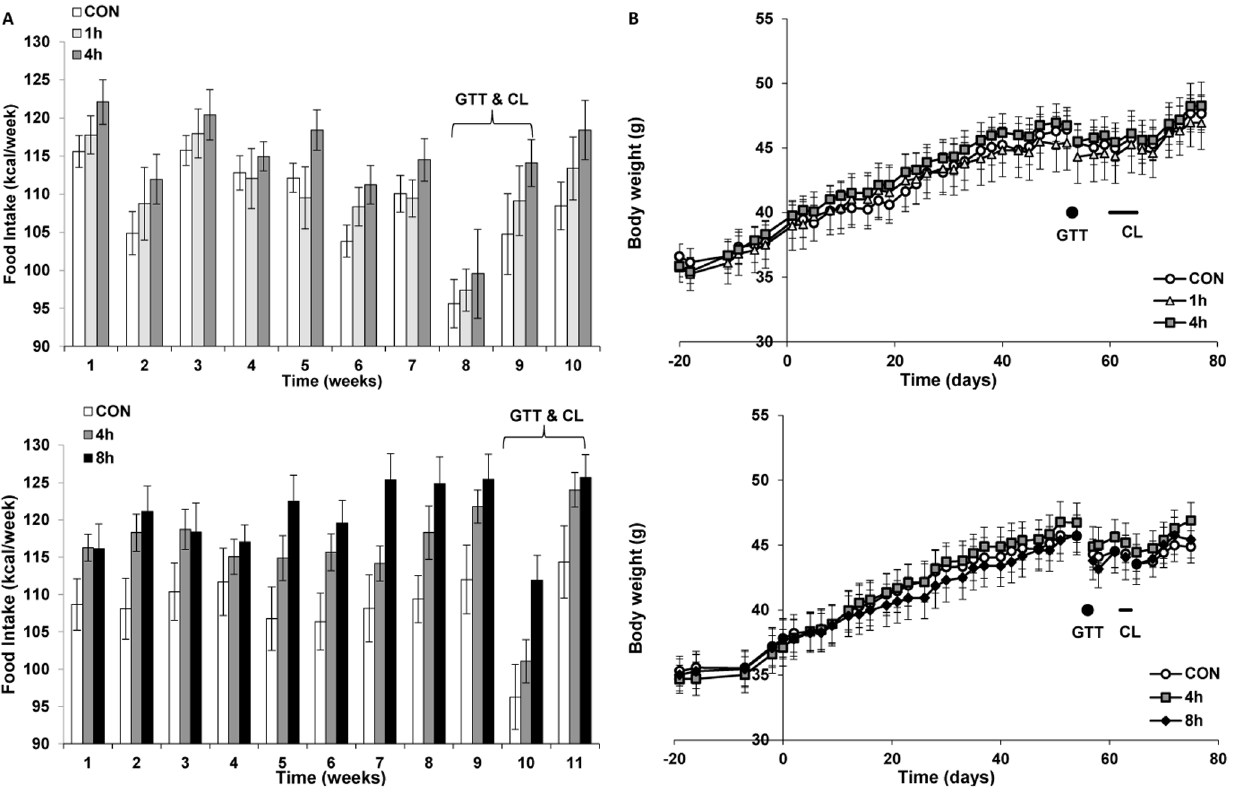
Figure 1. Cold exposure increases food intake, but not body weight. A: Caloric intake and B: body weight during ICE # 1 (top) and ICE # 2 (bottom) experiments were measured three times per week on days of cold exposure. Timing of the intra-peritoneal glucose tolerance tests (GTT) and CL316243 treatment (CL) are indicated. Data are mean 6 SE, N=8/group. The 8 h group had higher food intake as assessed by repeated measures ANOVA (p , 0.05).